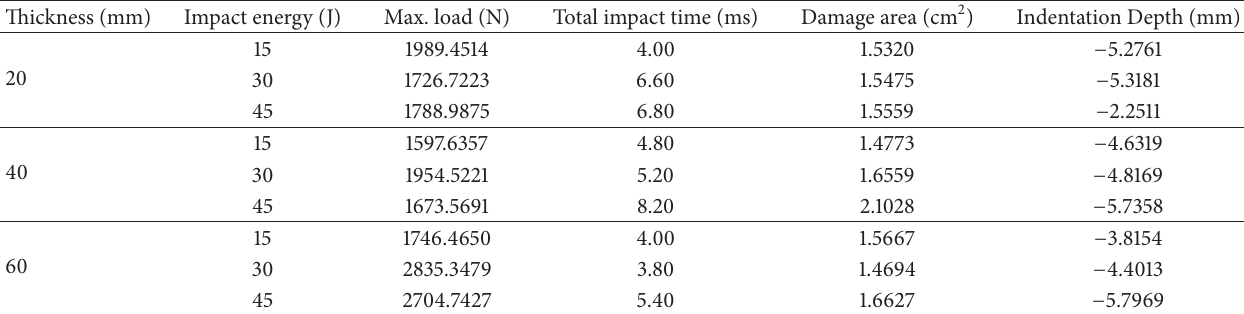
Table 2: Average impact parameters for sandwich samples with PP honeycomb core impacted at 15, 30, and 45 J for core thicknesses of 20, 40, and 60